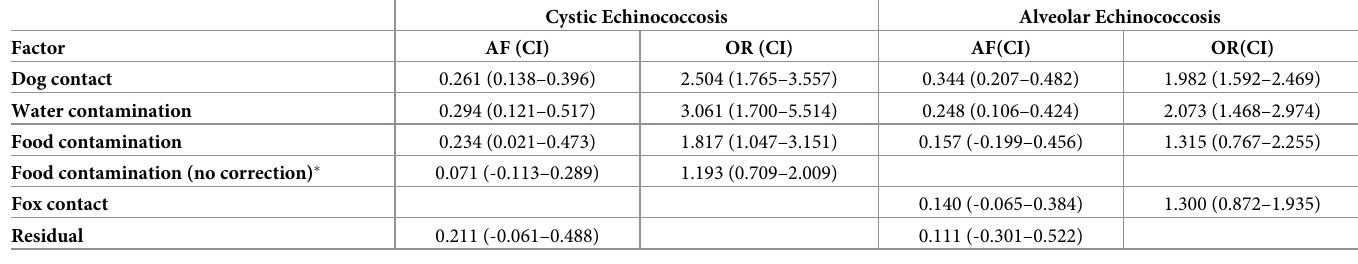
Table 1. Estimated AF as the source of infection for cystic and alveolar echinococcosis and corresponding OR following meta-analysis of selected studies.